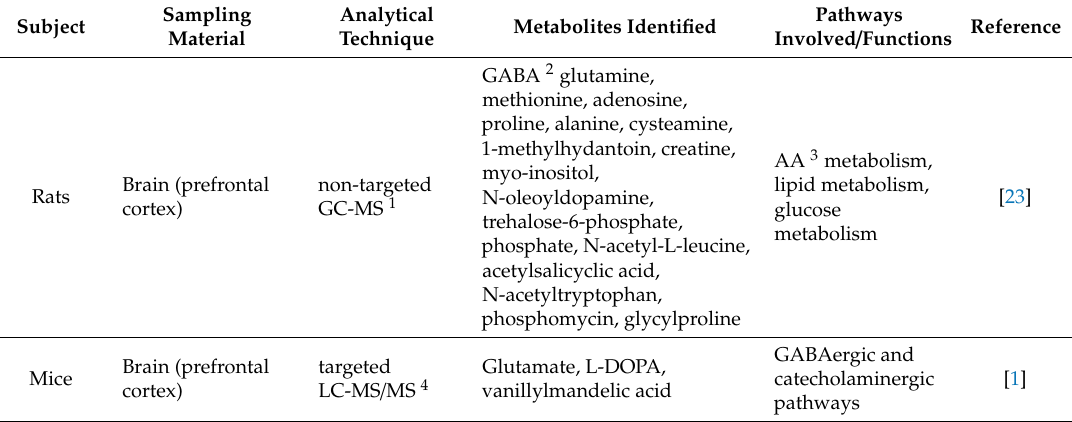
Table 1. Possible biomarkers identified in animal models of